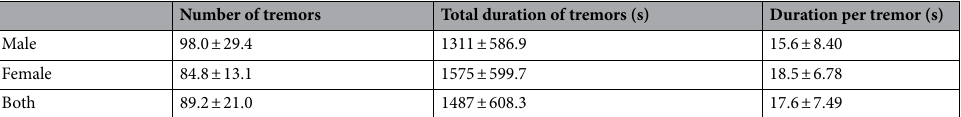
Table 1. Number and duration of tremors during a 60-min observation period in Prkar1b -deficient rats. Data are represented as mean ± SD. Data were obtained from 17- to 28-week-old male (n = 3) and 19- to 28-week- old female (n = 6) rats. There was no difference between sexes in the number of tremors ( P = 0.30), total tremor duration ( P = 0.31), or duration per tremor ( P = 0.35).